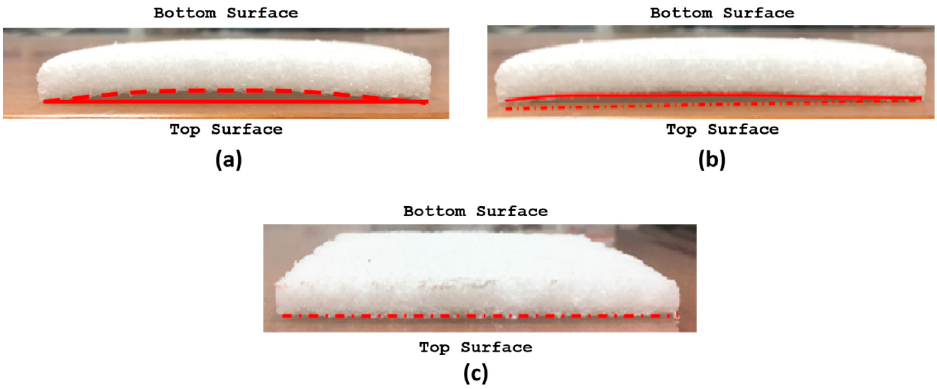
Figure 3. Side view of thin aerogel composite sheet obtained using different mold designs and process; ( a ) MDP00 ( b ) MDP01 ( c ) MDP02.